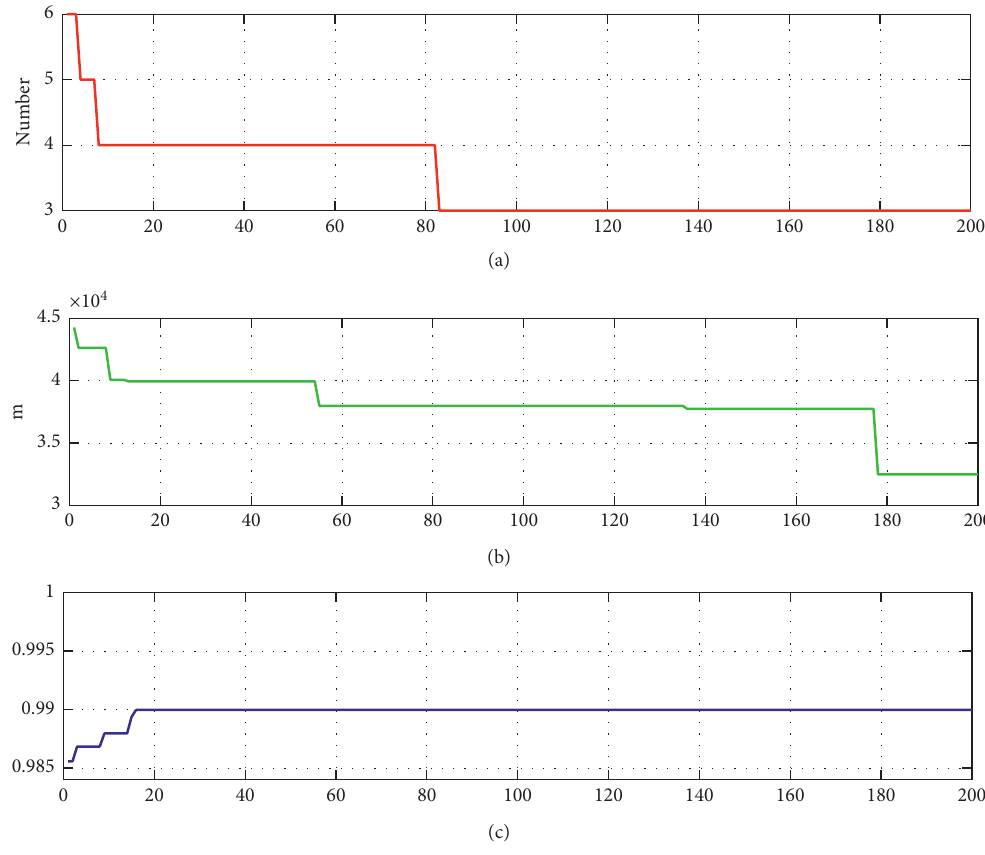
Figure 8: Process of seeking the optimal strategy. (a) Truck number. (b) Total length. (c) Demand satisfaction rate.